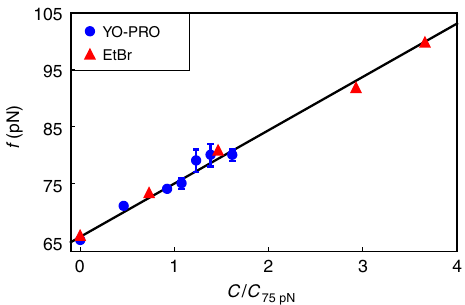
Fig. 4 Overstretching force as a function of intercalator concentration for YO-PRO (blue circles, error bars, s.d., n h i = 6.3) and ethidium bromide (red triangles) fi tted with a linear relation. The concentrations are scaled on the concentration required to shift the overstretching force to 75 pN (542nM for YO-PRO, 6.8 nM for EtBr). The obtained slopes are (1.7 ± 0.1) × 10 − 2 pN nM − 1 for YO-PRO and (1.4 ± 0.1) pN nM − 1 for EtBr. The data on EtBr is extracted from results previously published in ref.